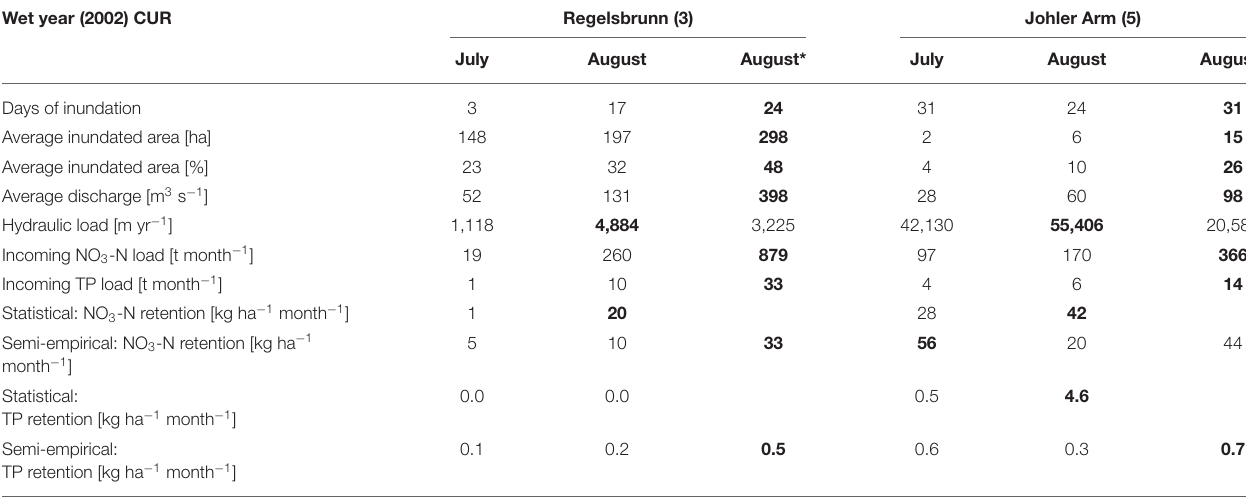
TABLE 3 | Floodplain characteristics of two differently restored floodplains for July and August 2002 (wet